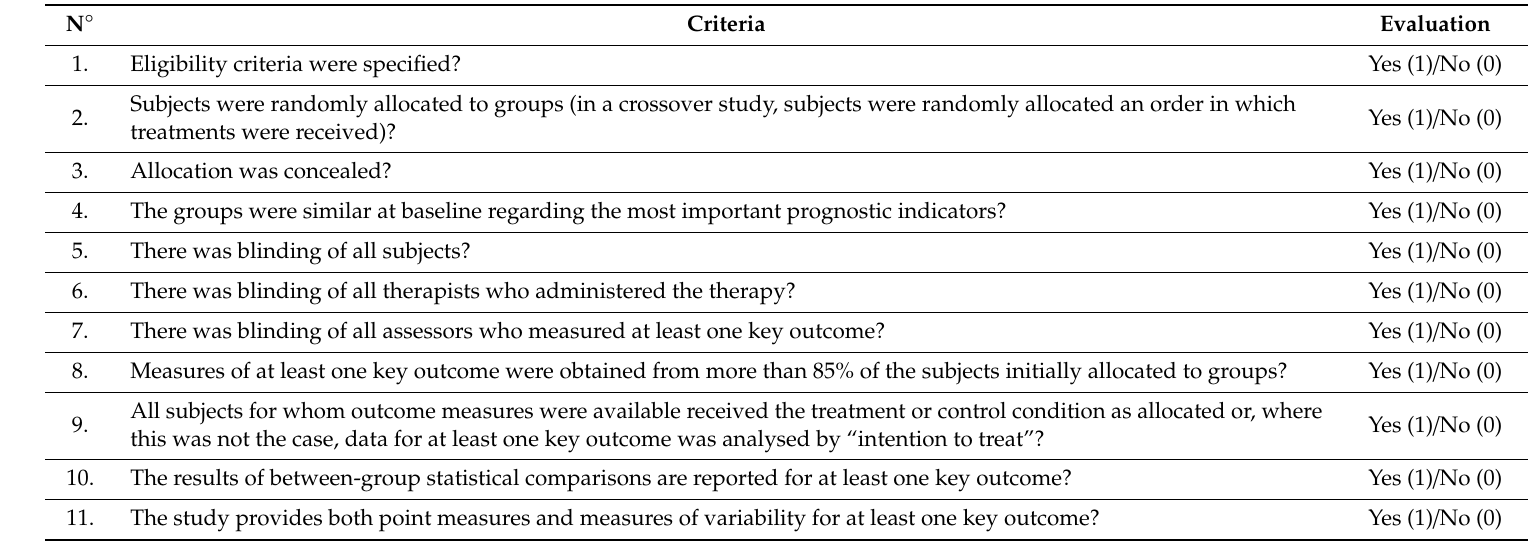
Table A5. Pedro-scale adapted from “The PEDro scale is a valid measure of the methodological quality of clinical trials: a demographic study.” by de Morton N.A., 2009, Aust J Physiother 55(2), p. 131 [43].